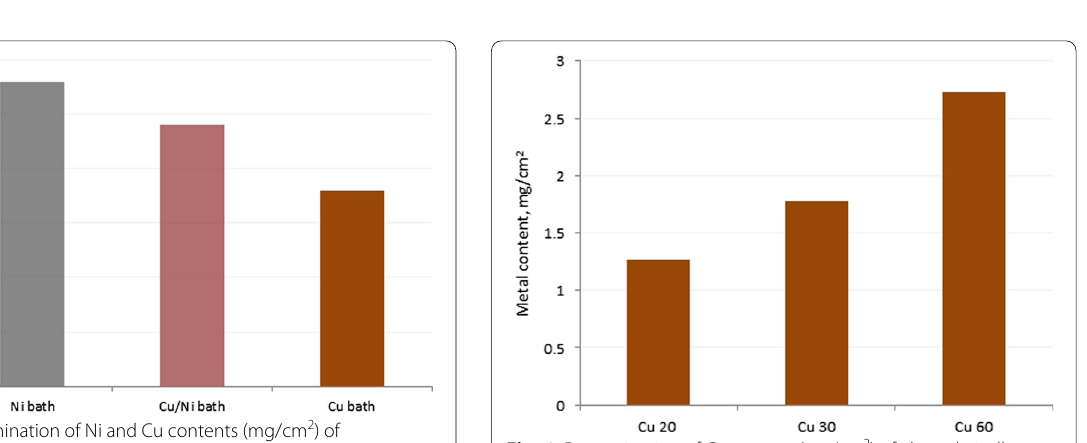
with Ni was 53 and Cu 51 and mixture Ni/Cu was 51 HB, while the lowest hardness was 50 HB of the sample elec- trolytically colored with Cu and anodized for 20 min.